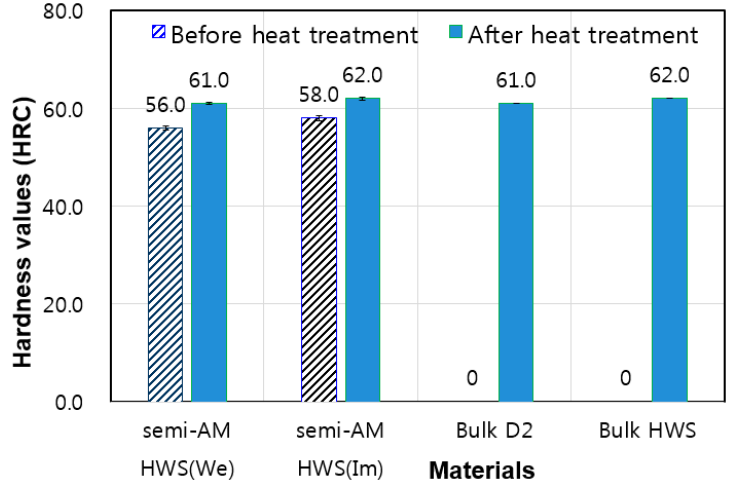
Figure 6. The hardness comparison of the three materials.